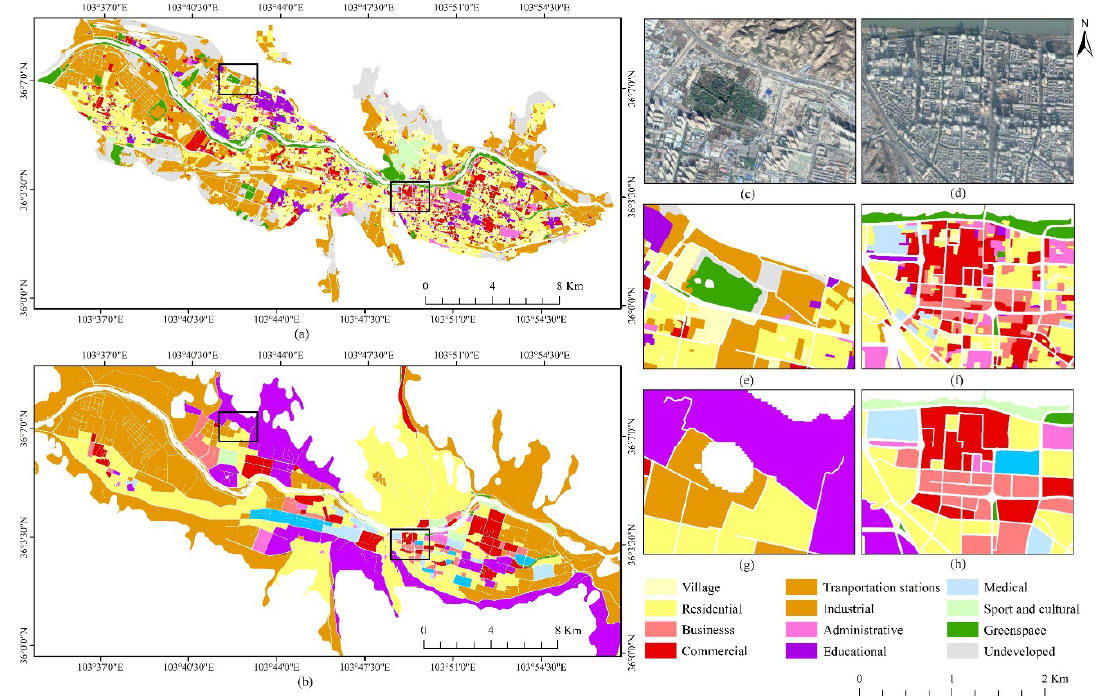
Figure 5. Comparison of the results of this paper with the results of the essential urban land use categories (EULUC) in the main city of Lanzhou. ( a ) overview mapping results implemented in this study; ( b ) overview mapping results of EULUC; ( c , d ) Google images corresponding to the local mapping areas; ( e , f ) local details of Figure 5a; ( g , h ) local details of Figure 5b.